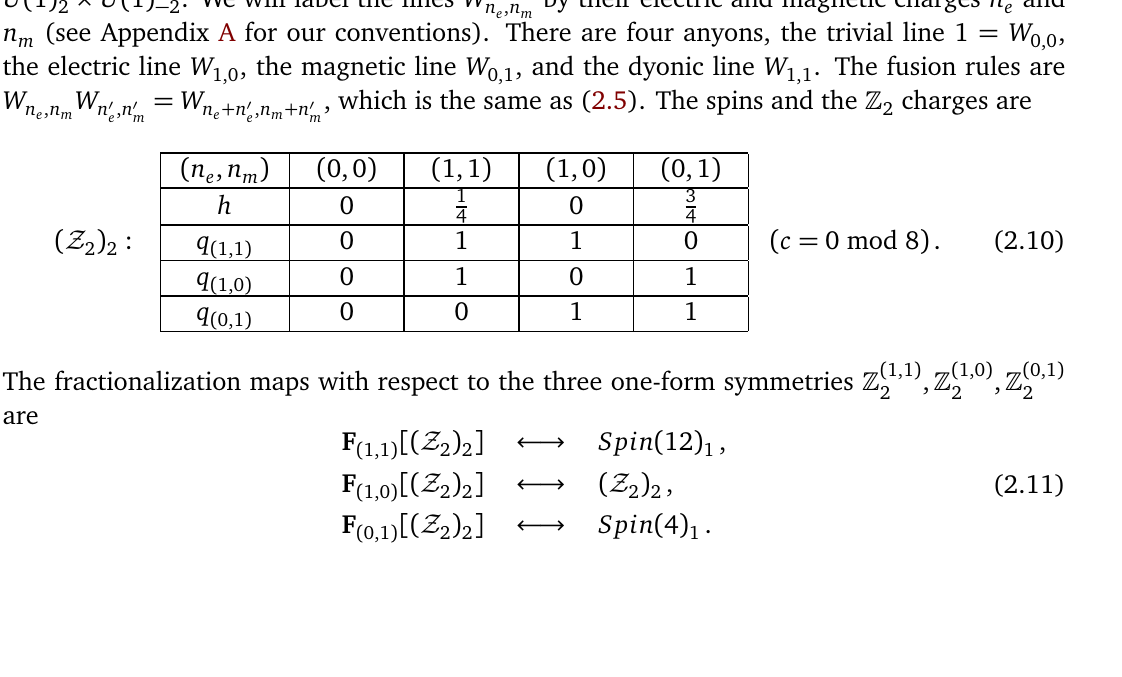
The fusion rules of Spin ( 8 )